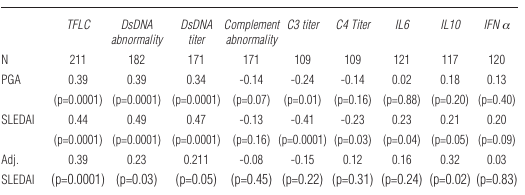
Table 1. Correlation of markers with disease